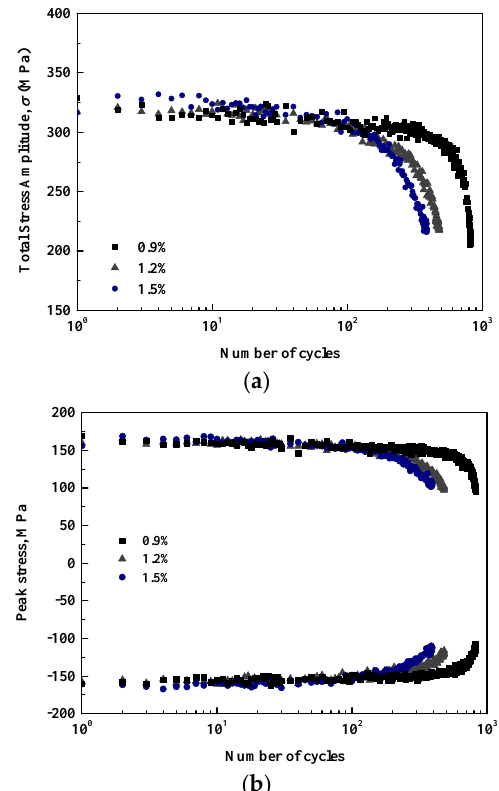
Figure 6. Cyclic stress response curves of Alloy 617 at 950 °C: ( a ) Stress amplitude path behavior; ( b ) Peak and tensile compressive stresses response as a function of the number of cycles.